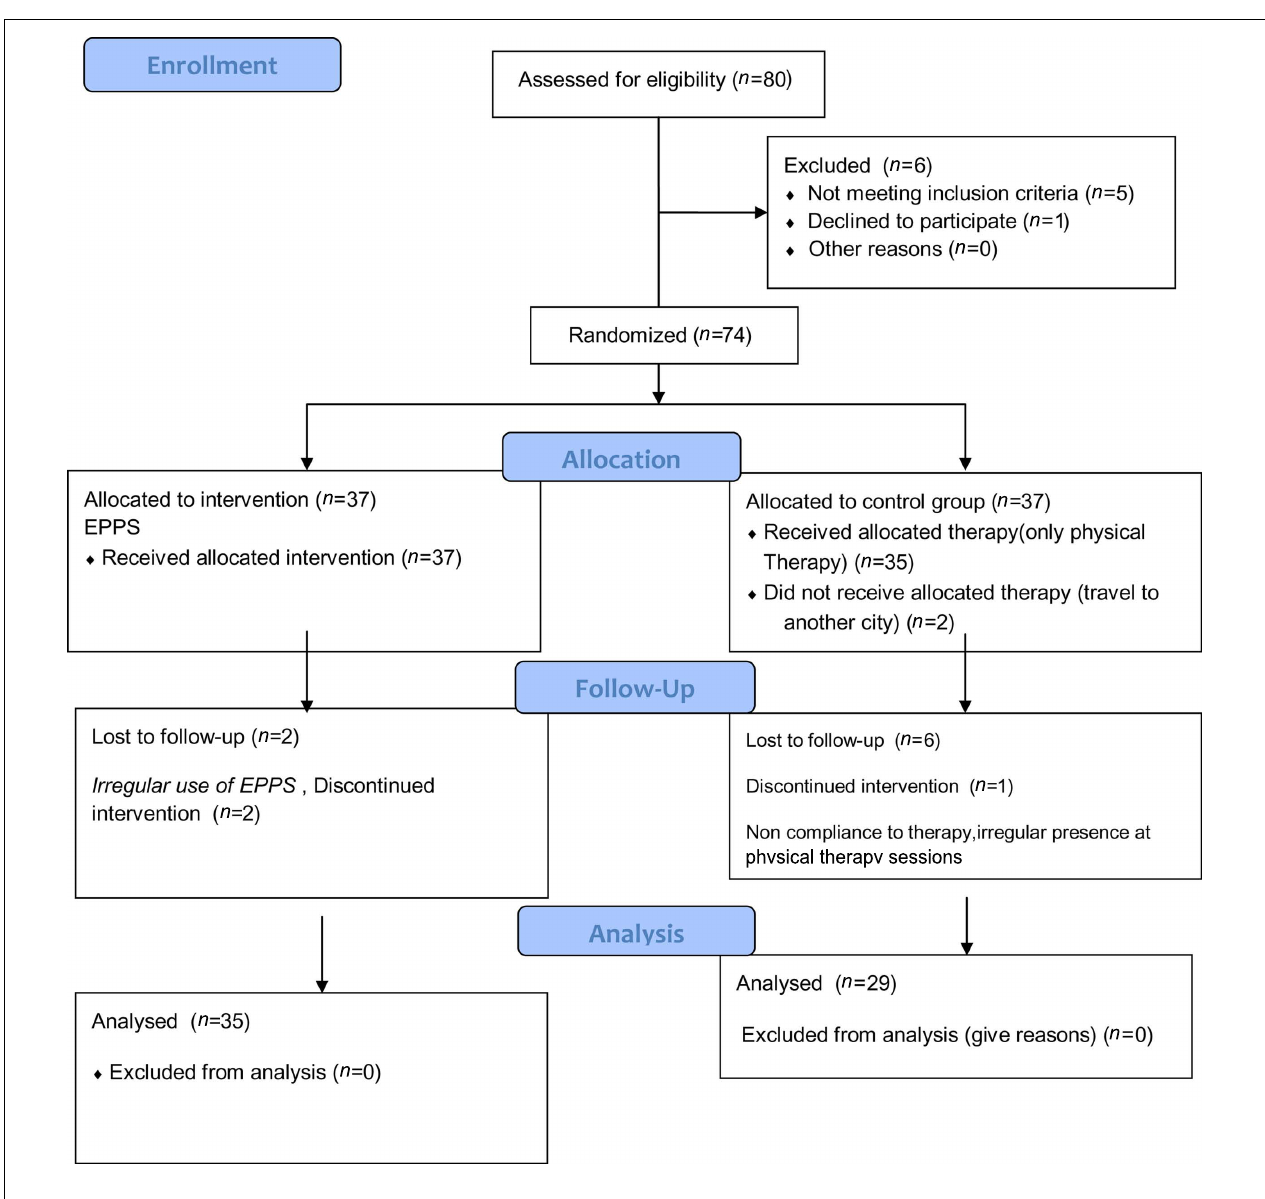
FIGURE 1 | Flow chart of the